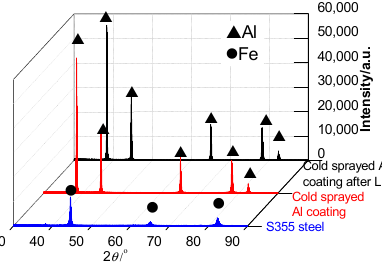
Figure 2. XRD analysis of cold sprayed Al coatings before and after LR.